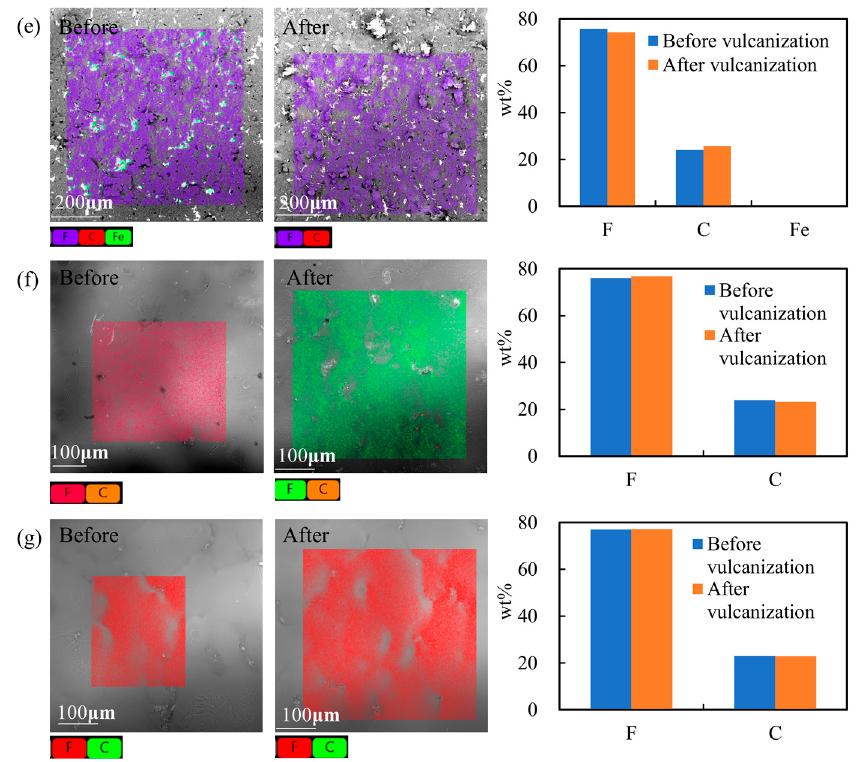
Figure 8. Surface micro-morphology and element composition of the specimen before and after vulcanization: ( a ) without coating, ( b ) nano-ceramic coating, ( c ) bilayer waterborne PTFE coating, ( d ) Whitford Xylan 8840 coating, ( e ) PTFE coating, ( f ) PFA coating, ( g ) FEP coating.